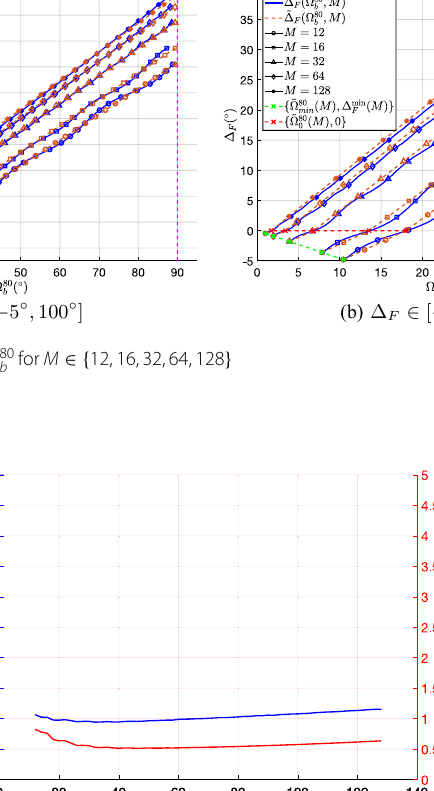
(cid:31) F versus (cid:31) 80 ˜